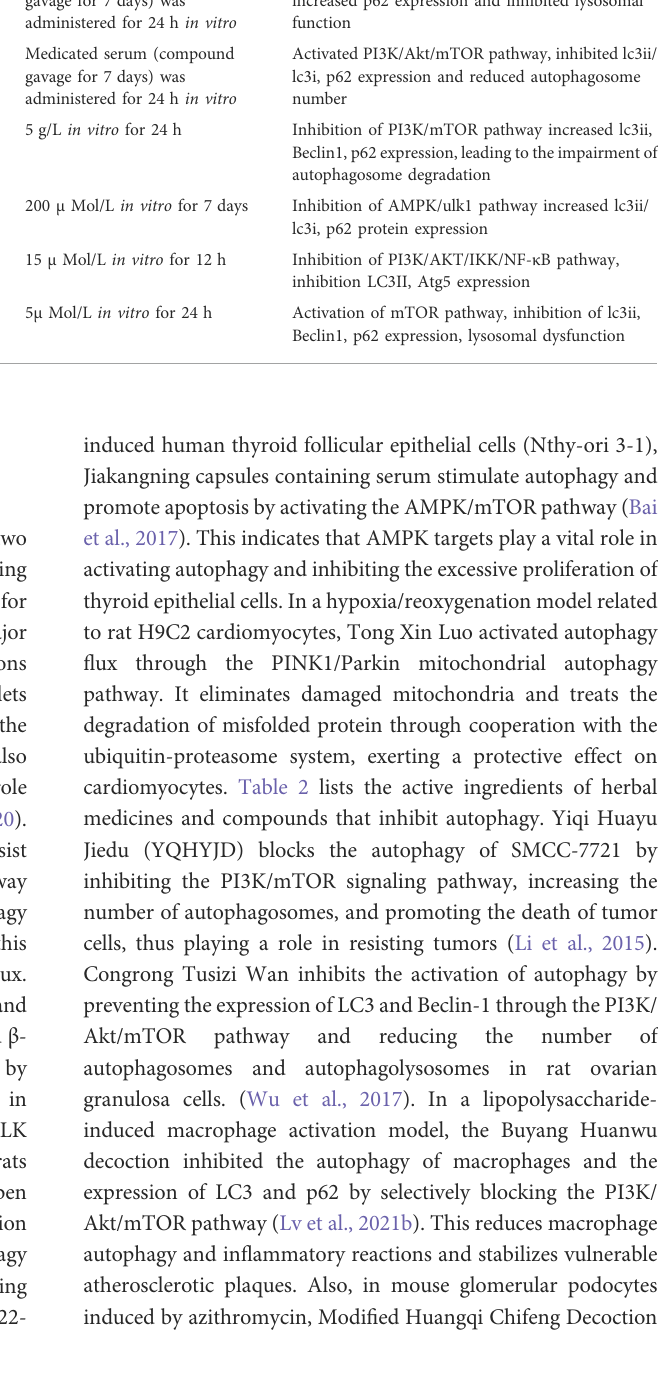
cardiomyocytes. Table 2 lists the active ingredients of herbal